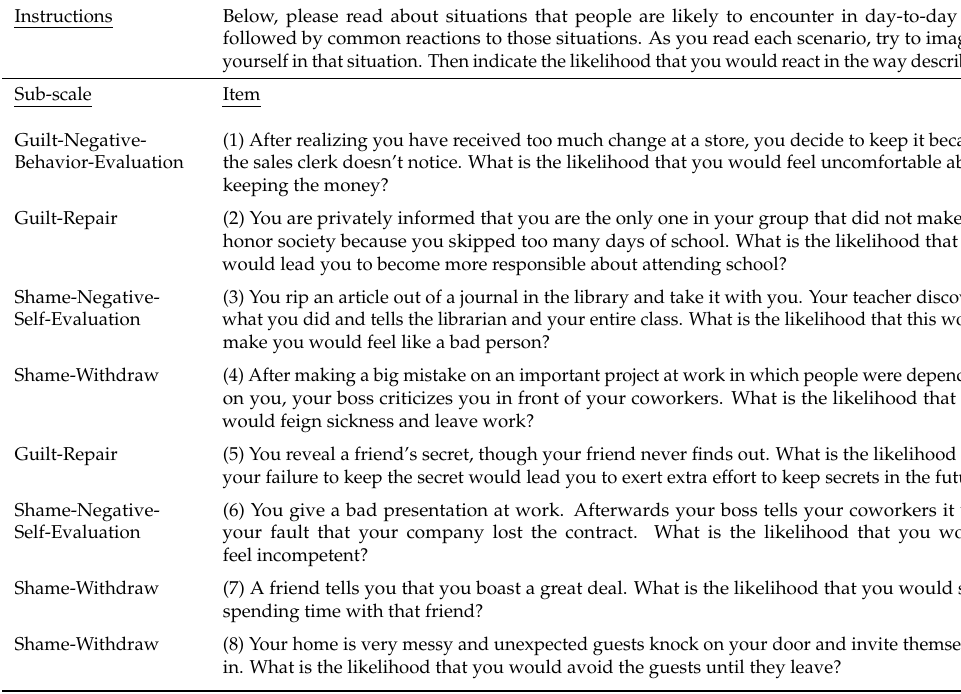
Table A1. Guilt and Shame Proneness Scale.